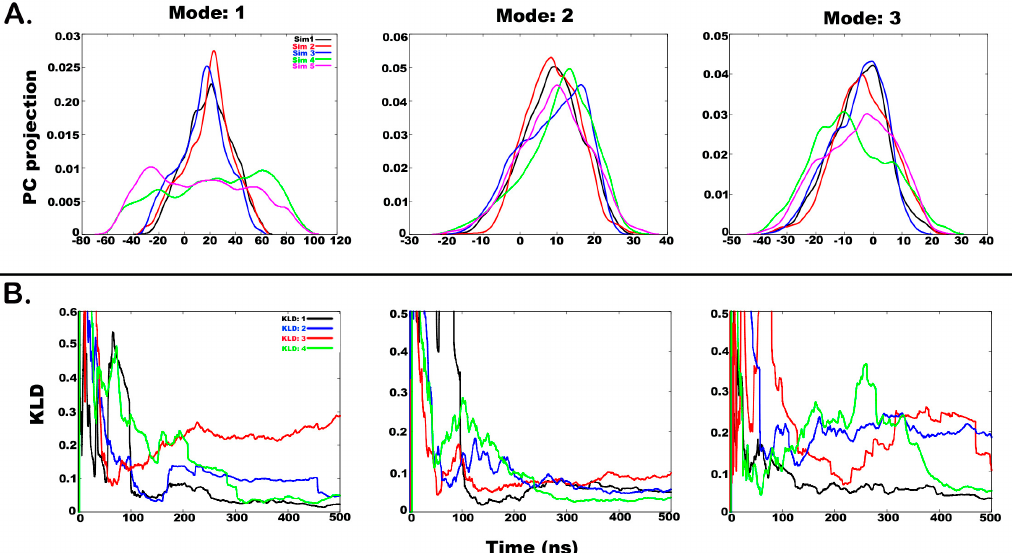
Figure 6. ( A ) Histograms of projection of principal component 1, 2, and 3 from all four simulations in chloroform where the last 1 μ s long simulation is treated in 2 parts. Histograms were calculated using a Gaussian kernel density estimator. ( B ) A measure of overlap between histograms from independent simulations calculated using Kullback-Leibler divergence method. The slope values lying below 0.025 indicate convergence between two independent runs.